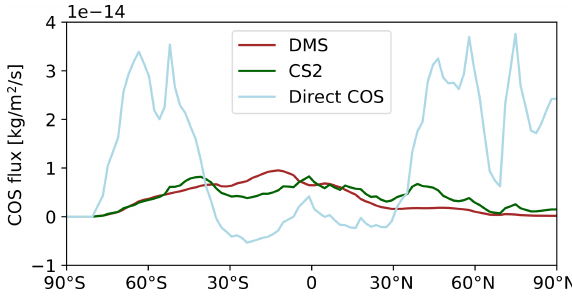
Figure 3. Zonal mean distribution of the prior oceanic fluxes as a function of latitude averaged over the year 2010. The direct COS emissions are shown in blue whereas the indirect COS emissions through DMS (CS 2 ) are depicted in brown